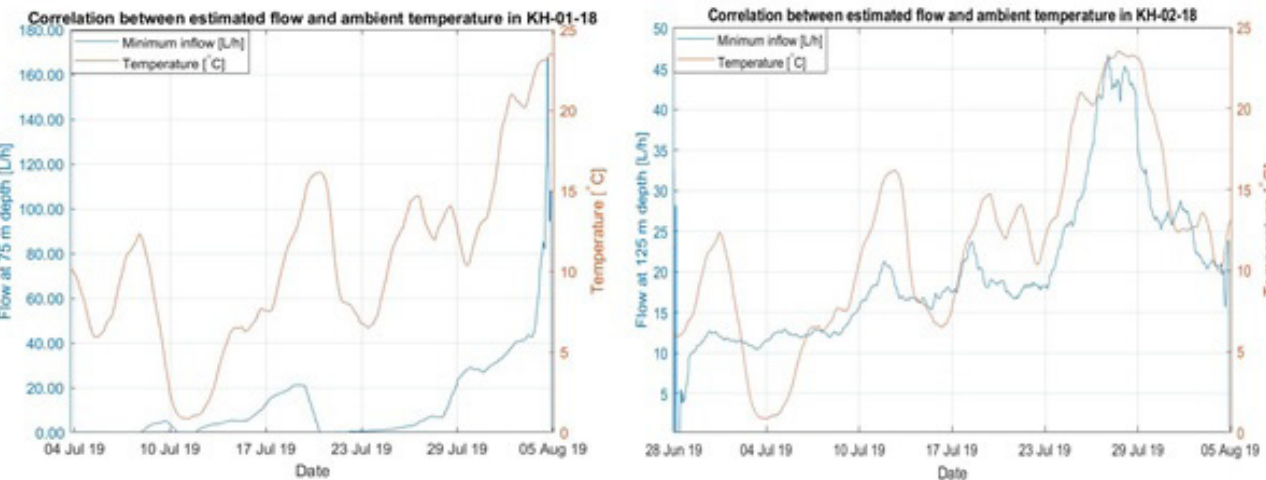
Figure 9. The left-hand side of the figure shows the estimated groundwater flows in KH-01-18 (moving daily averages) and their correlation with ambient temperature (moving daily averages): The highest correlation factor found was 0.68, when temperature data were moved 9.0 days forward in time. The right side of the figure shows the estimated groundwater flow in KH-02-18 (moving daily averages) and its correlation with ambient temperature): The highest correlation factor found was 0.84, when temperature data were moved 1.4 days forward in